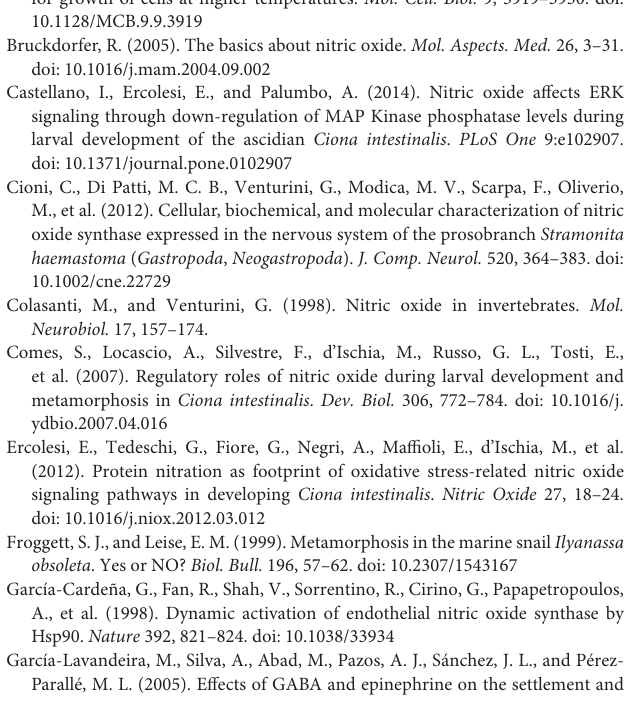
FIGURE S1 | Tissue transcriptional analysis of M. coruscus NOS and HSP90 mRNA. (a) Levels of McNOS mRNA in different tissues. (b) Levels of HSP90 mRNA in different tissues. Expression of McNOS and HSP90 transcripts in seven tissues from five mussels was quantified by quantitative real-time PCR (RT-qPCR). The EF-1 α gene was used an internal control to normalize the relative mRNA levels of NOS . Results are means ± SEM ( n = 6), and bars with different letters are significantly different ( p <